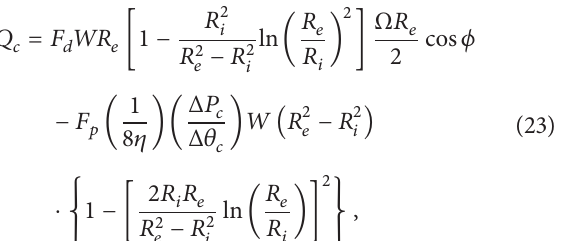
respect to the channel length ( 𝑍 ). The cross-channel flow rate is equal to zero, the relative velocity of the barrel has the same direction as the main flow, and the pressure change